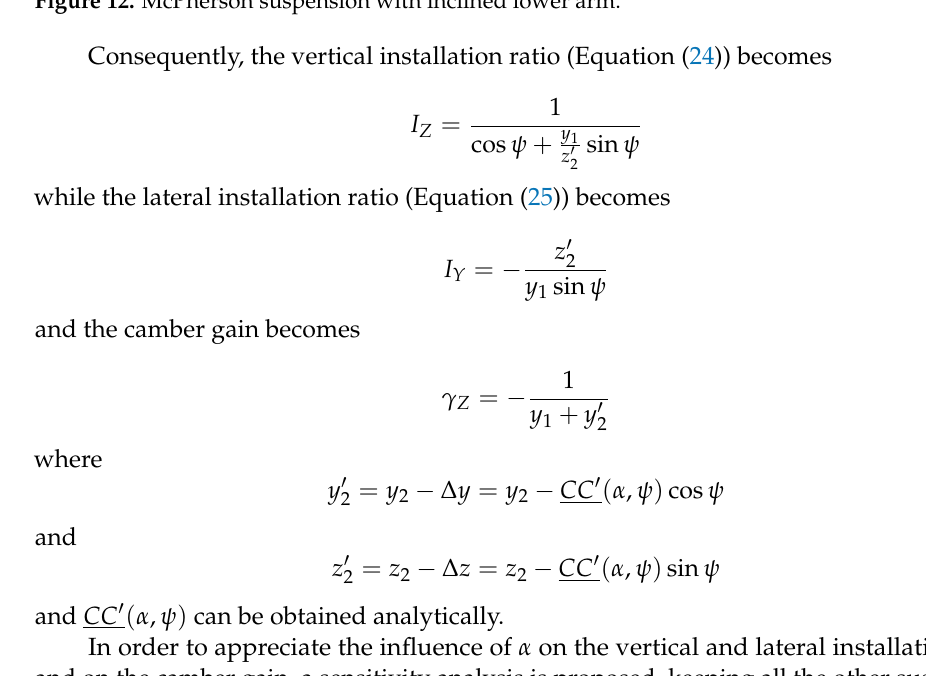
Figure 12. McPherson suspension with inclined lower